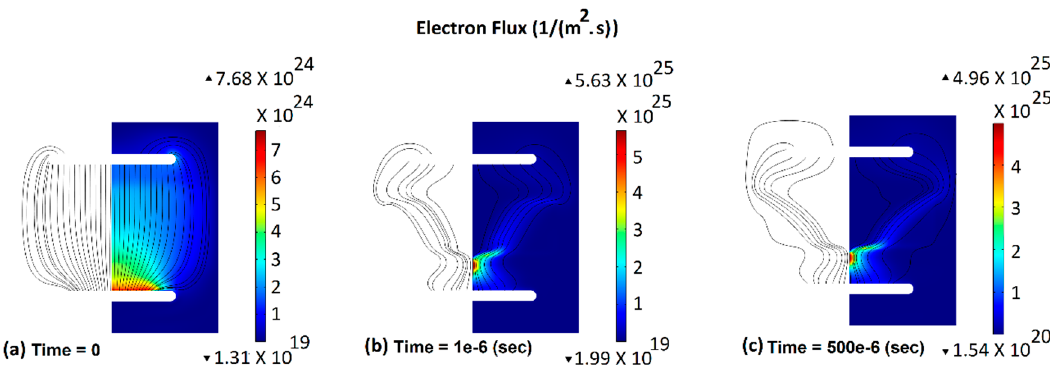
Figure 2. Distribution of the electron flux at different time steps: ( a ) initial moment, ( b ) 1 µSec and ( c ) 500 µSec after application of 20 mT UFTMF.